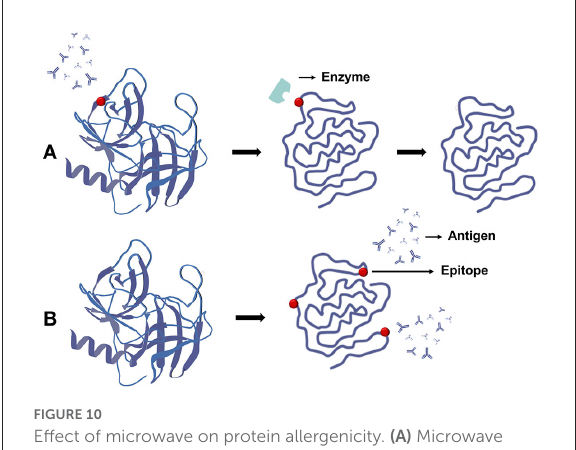
FIGURE10 Effect of microwave on protein allergenicity. (A) Microwave promotes the degradation of protein epitopes and reduces allergenicity. (B) Microwave promotes the generation of new antigenic determinants and increases